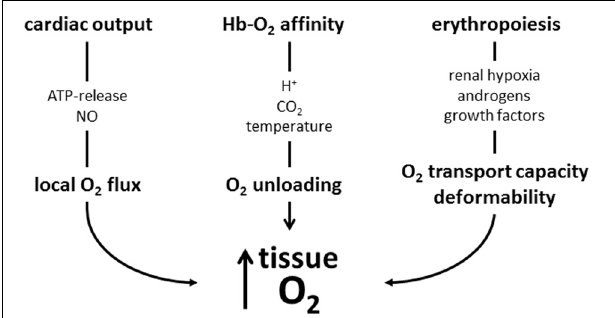
FIGURE 3 | Schematic presentation of mechanisms increasing muscle oxygen supply acutely during exercise and by training discussed in this review. During exercise local blood flow is increased by mediators causing local vasodilation, which is supported by red blood cell-mediated NO production. Acidosis, CO 2 and hyperthermia decrease Hb-O 2 -affinity and enhance O 2 release from its bond to hemoglobin. These improvements may in part be blunted by increased blood viscosity (not shown in scheme). Training stimulates erythropoiesis to increase the O 2 -transport capacity. The newly formed cells also have an improved deformability which facilitates muscle blood flow. Training also increases red blood cell 2,3-DPG (not shown), which further enhances O 2 release from